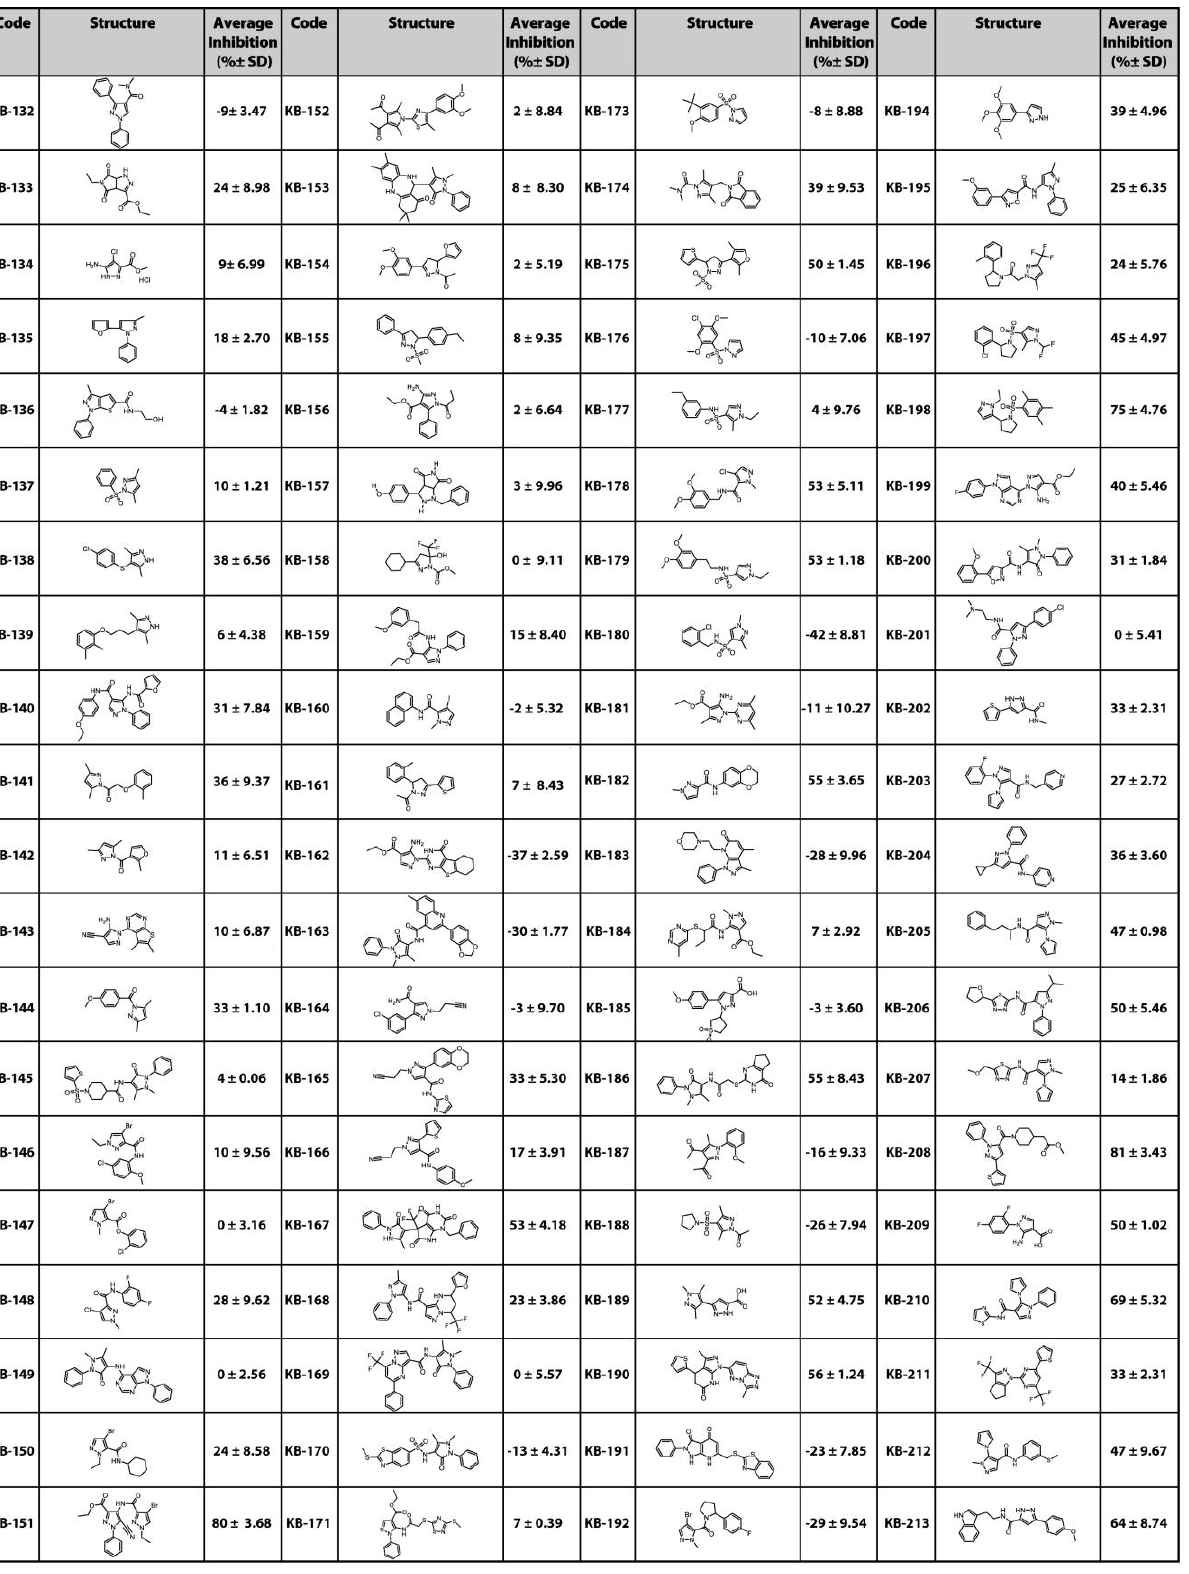
Figure 2. Chemical structures and % inhibition (mean ± SD) in MMA of the 80 compounds prelimi- narily evaluated in vitro. Compounds were screened at 5 µM and compared to the reference compound, intravenous immunoglobulin (IVIG) at 1 mg/mL.